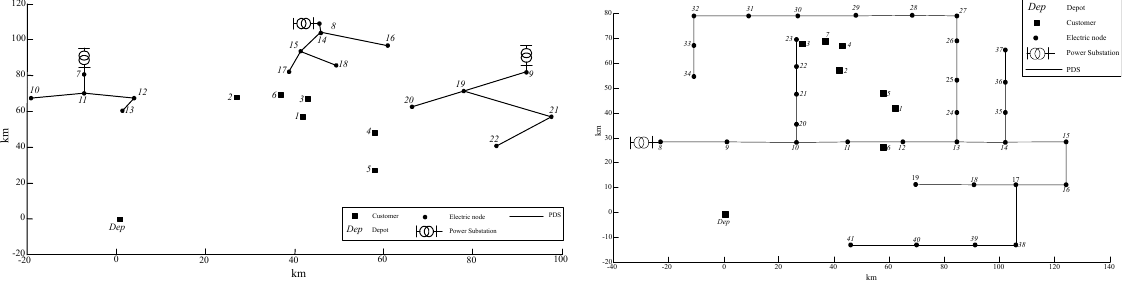
Fig. 4. Coupling between Pn6k2 and DS16N Fig. 5. Coupling between Pn7k3 and DS34N